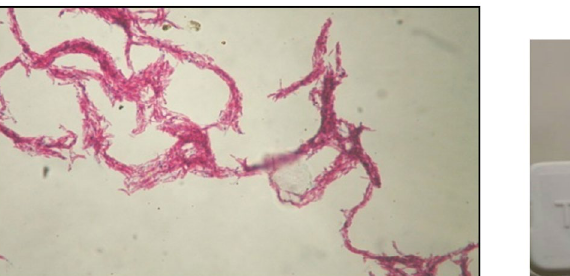
Fig. 1. Region of the study (highlighted districts).